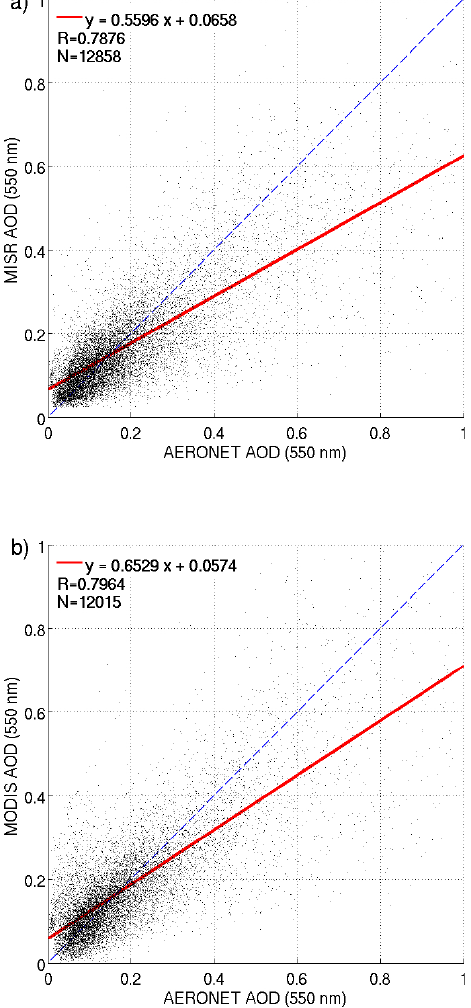
Fig. 1. (a) Comparison of monthly AERONET aerosol optical depths (AODs) and monthly MISR AODs collocated in time and space. (b) Comparison with MODIS AODs. The T42 data in the 2001–2010 period is used here. The solid red line in each panel rep- resents the linear regression, and the dashed blue line shows a slope of 1.0. R denotes the correlation coefficient, and N the number of the collocated data.